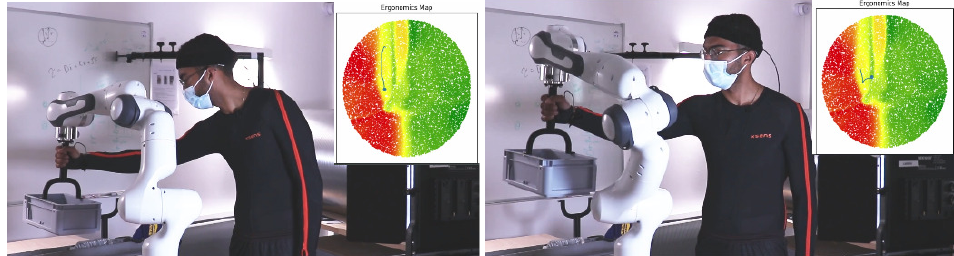
Figure 6. Experiment 2: collaborative object transportation. The human is physically interacting with the Franka robot. On the right of each photo, the Latent Ergonomic Map. The current human posture is a point on the map while the line that is attached to it represents the previous human